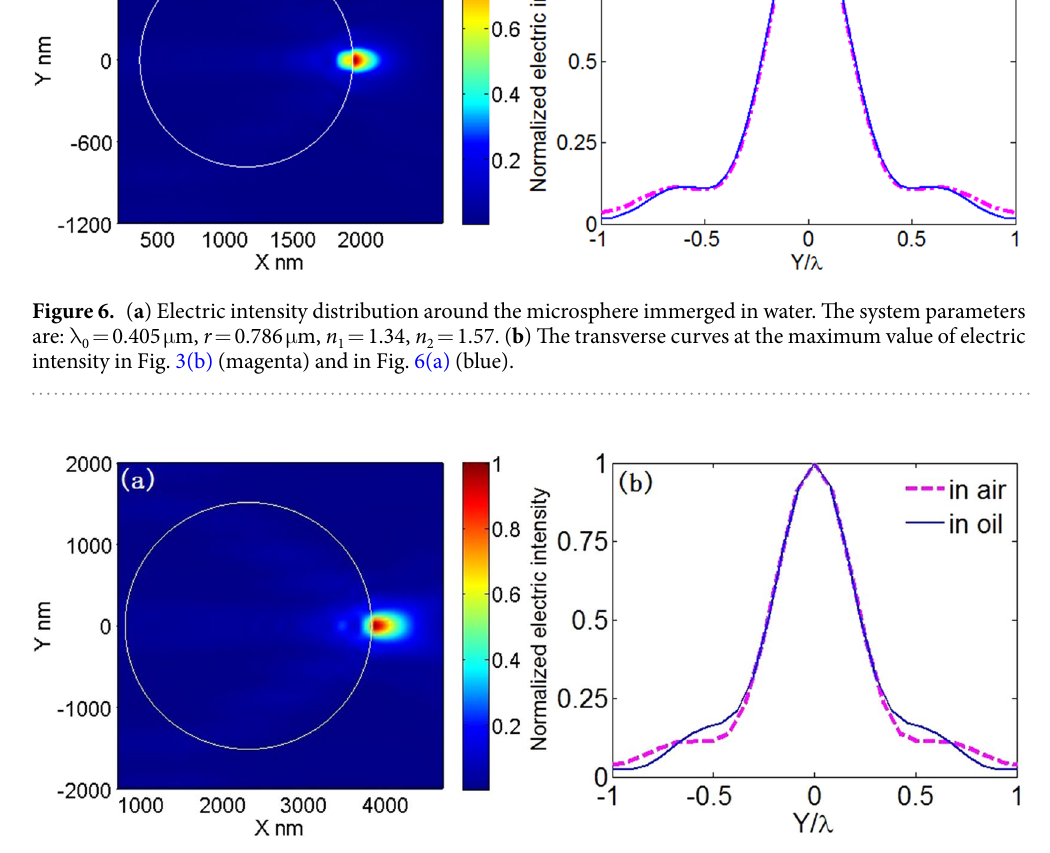
Figure 7. ( a ) Electric intensity distribution around the microsphere immerged in water. The system parameters are: λ 0 = 0.69 μ m, r = 1.515 μ m, n 1 = 1.515, n 2 = 1.77. ( b ) The transverse curves at the maximum value of electric intensity in Fig. 3(b) (magenta) and in Fig. 7(a)